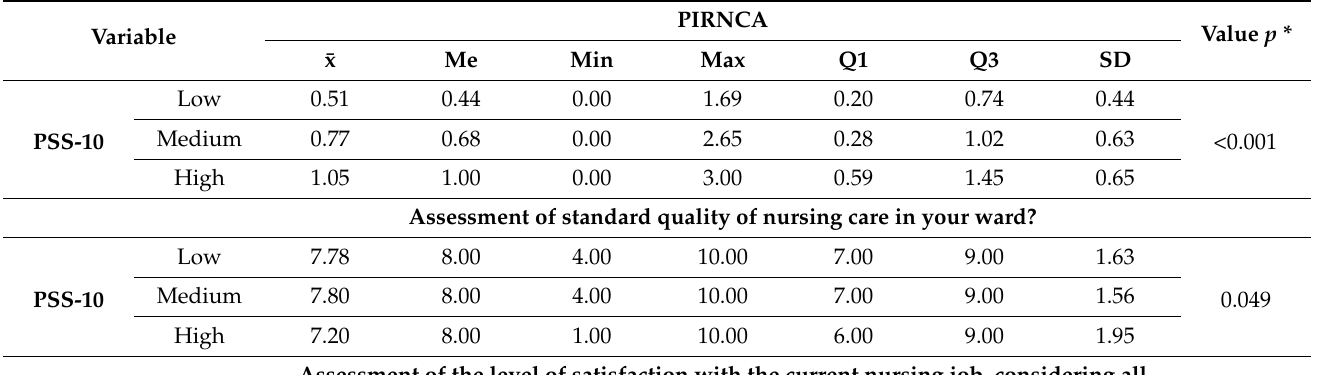
Table 4. Results of the correlation analysis of PSS-10 and PIRNCA in groups showing differences in terms of the stress